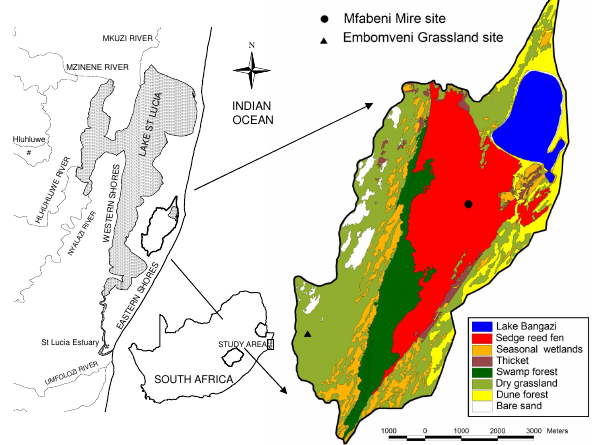
Fig. 1. The location of the Mfabeni Mire and Embomveni Dune sites on the Maputaland coastal plain. The Mfabeni Mire is repre- sented by the sedge reed fen vegetation